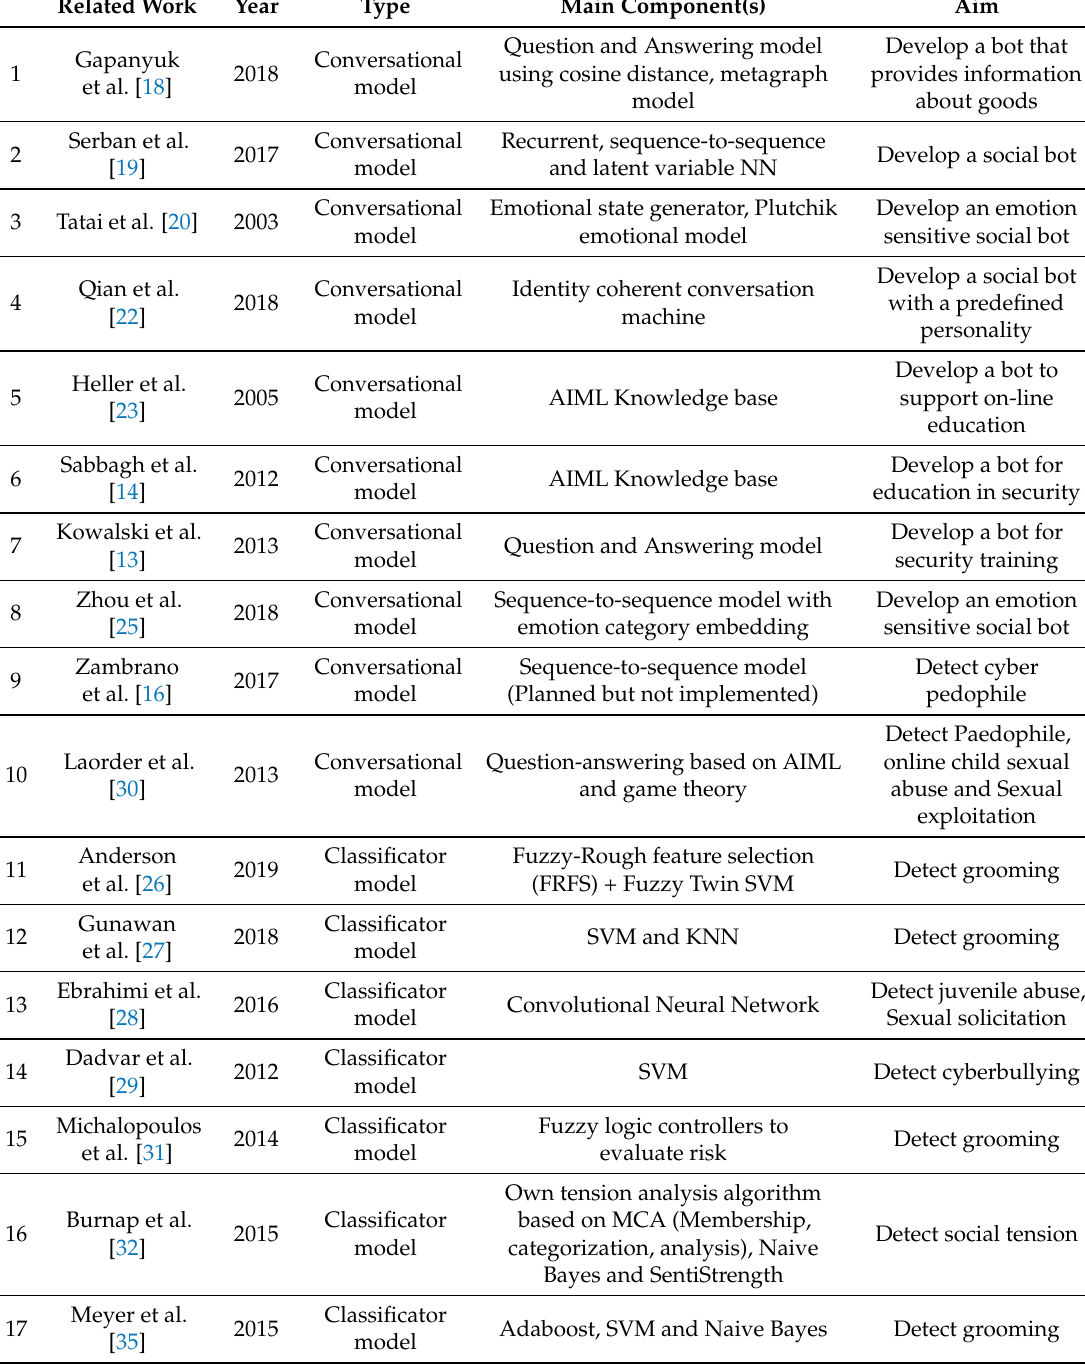
Table 1. Comparative table of the analyzed related